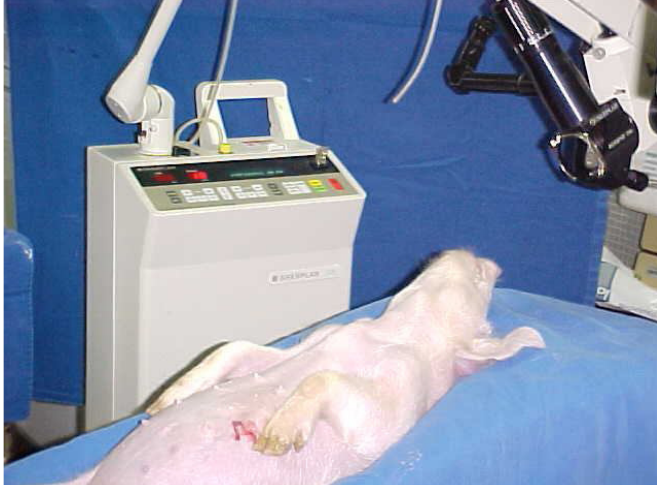
FIGURE 1 – Animal’s surgical position when anesthetized on